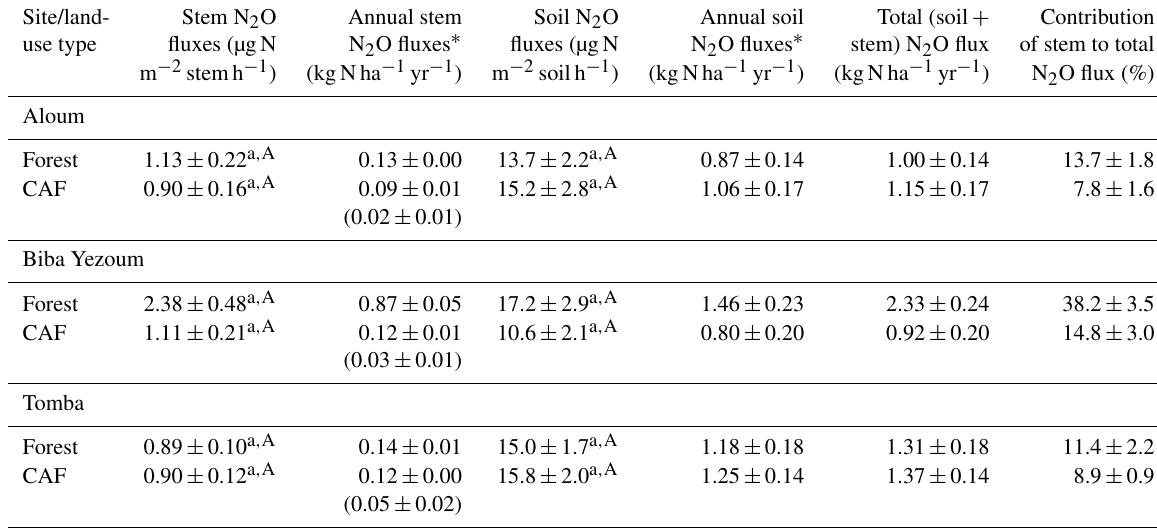
Table 2. Mean ( ± SE, n = 4) stem and soil N 2 O emission as well as annual stem, soil and total (soil + stem) N 2 O fluxes from forest and cacao agroforestry (CAF) within each site in the Congo Basin, Cameroon. Means followed by different lowercase letters indicate significant differences between land-use types within each site, and different capital letters indicate significant differences among the three sites within a land-use type (linear mixed-effect models with Tukey’s HSD at P ≤ 0 . 05).